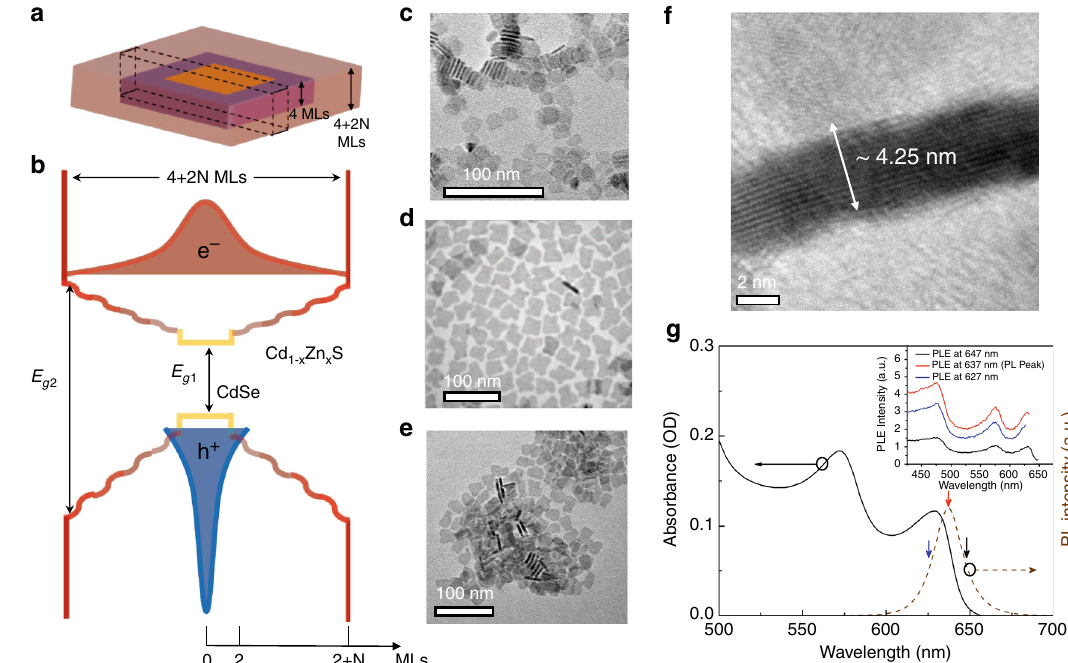
Fig. 1 Structure and characterization of the synthesized CQWs. a Schematic illustration of C/C@GS of CdSe/CdS@Cd 1-x Zn x S NPLs synthesized by using interfacial grading of shell in the vertical dimension as detailed in the text. b An approximate energy band diagram of the graded con fi nement potential in C/C@GS CQWs (based on band offset of bulk semiconductor 1 ) along with a schematic representation of the spatial distribution of electron (e − ) and hole (h + ) wavefunctions. Here, E g1 ≈ 1.75 eV and E g2 ≈ 2.7 eV for 4 + 2 N MLs, N = 4 20 . c – e TEM images of c 4-ML core, d core/crown, and e C/C@GS CQWs. f High-resolution TEM image of C/C@GS CQWs for 4 + 2 N MLs, N = 4. The thickness equals ~4.25 nm, which corresponds to 4 (core) + 2 × 4 (shell) MLs of core/shell heterostructure. g Absorbance (black line) and PL (dashed red line) spectra of CdSe/CdS@Cd 1-x Zn x S CQWs for 4 + 2 N MLs, N = 4. Inset shows the photoluminescence excitation (PLE) spectra of the sample at different (marked)